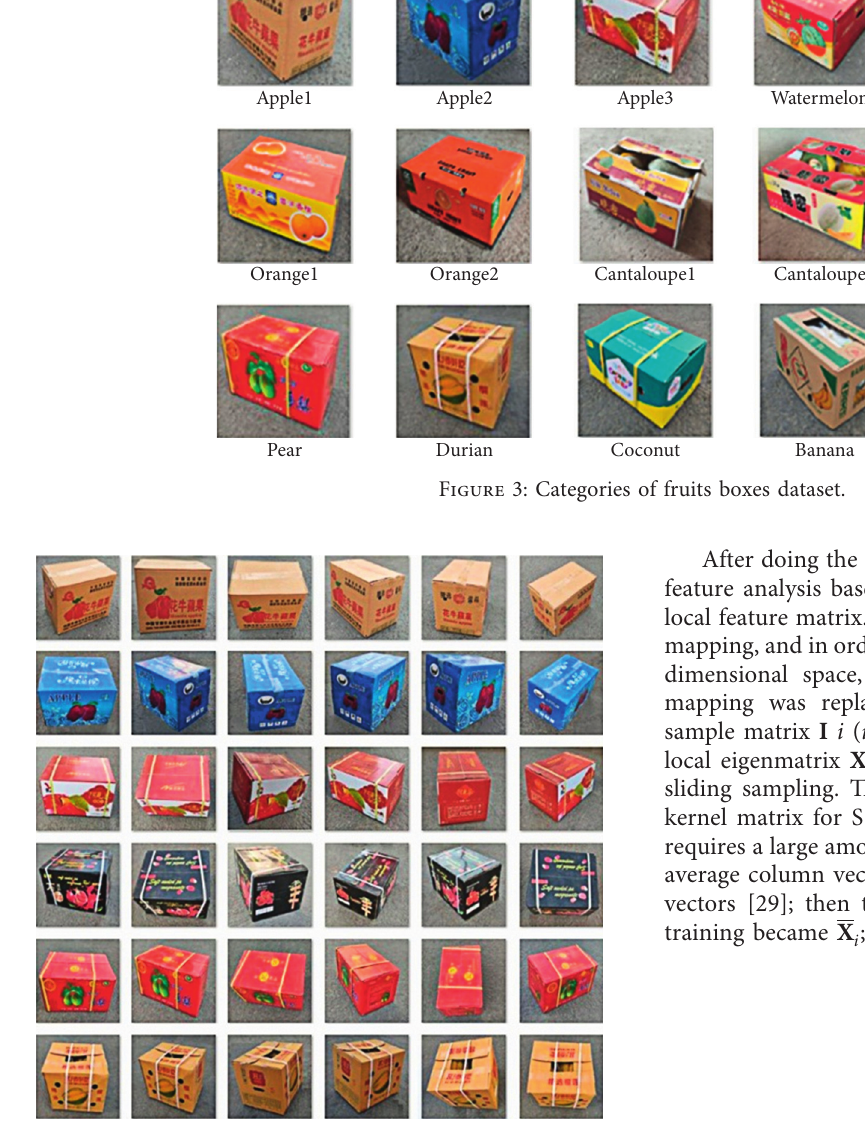
Figure 4: Collecting images in